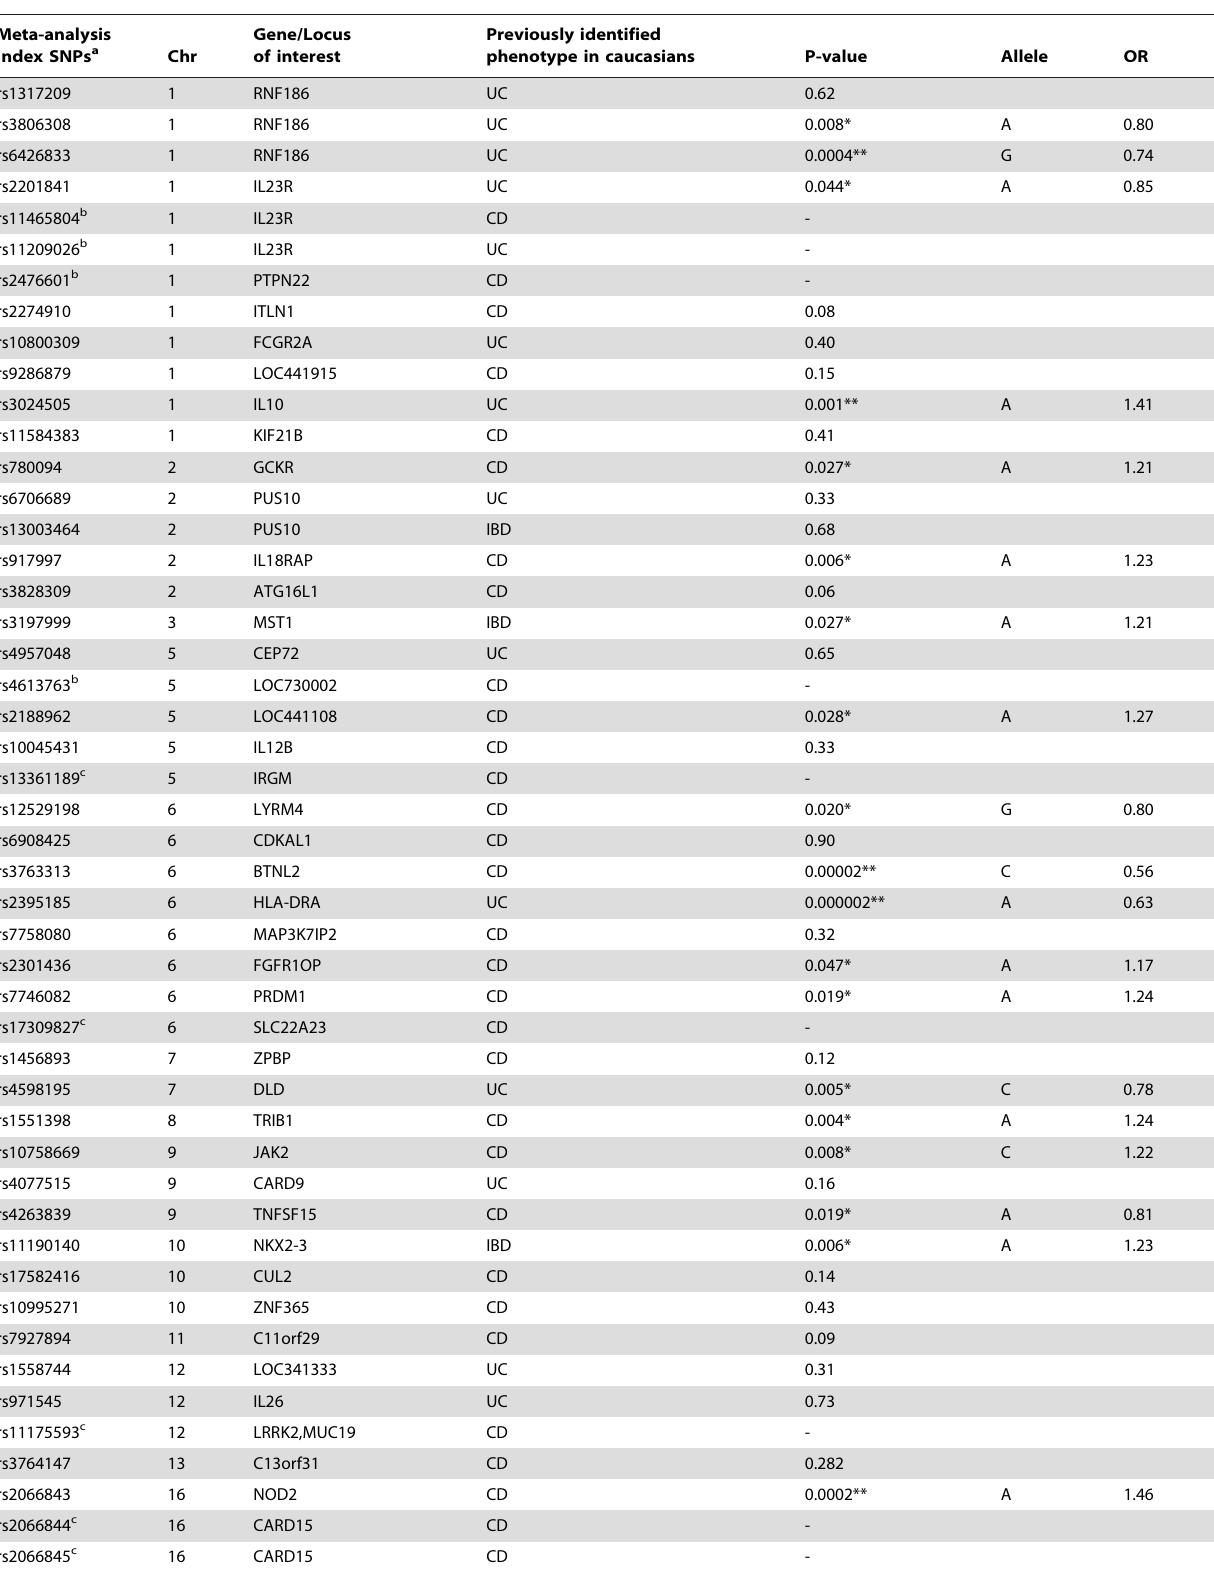
Table 1. Association status of 59 GWAS reported UC/CD specific susceptibility loci in a north Indian UC cohort.